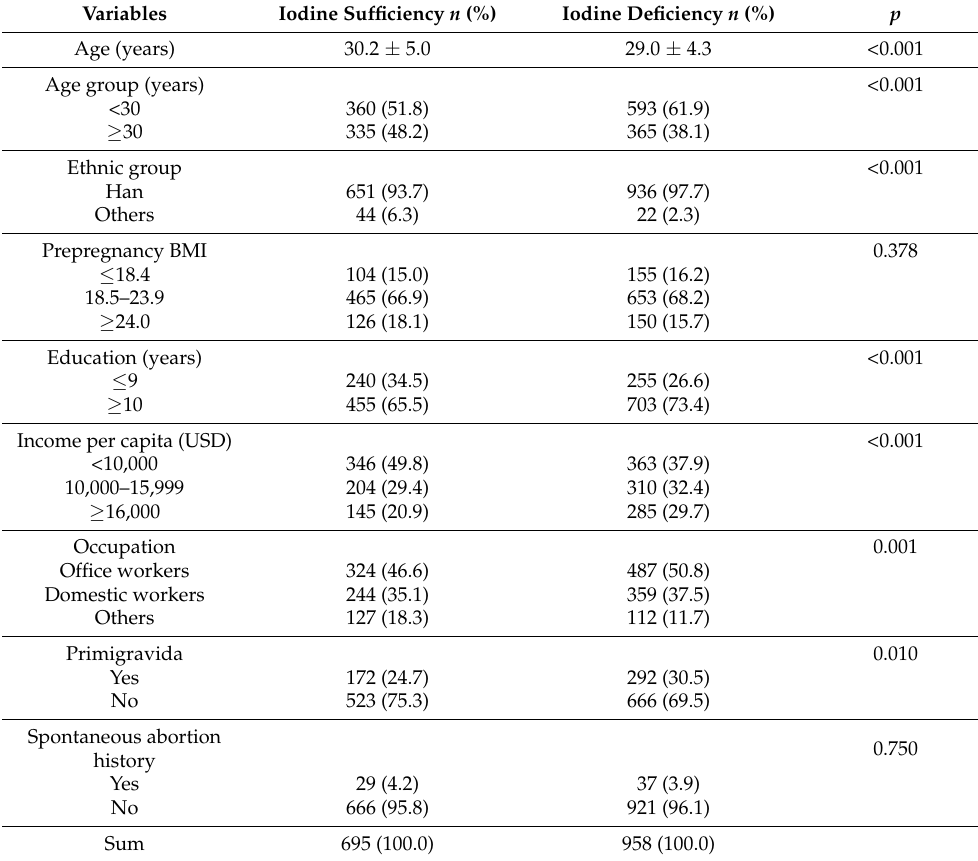
Table 1. Characteristics of the study participants compared by iodine intake.